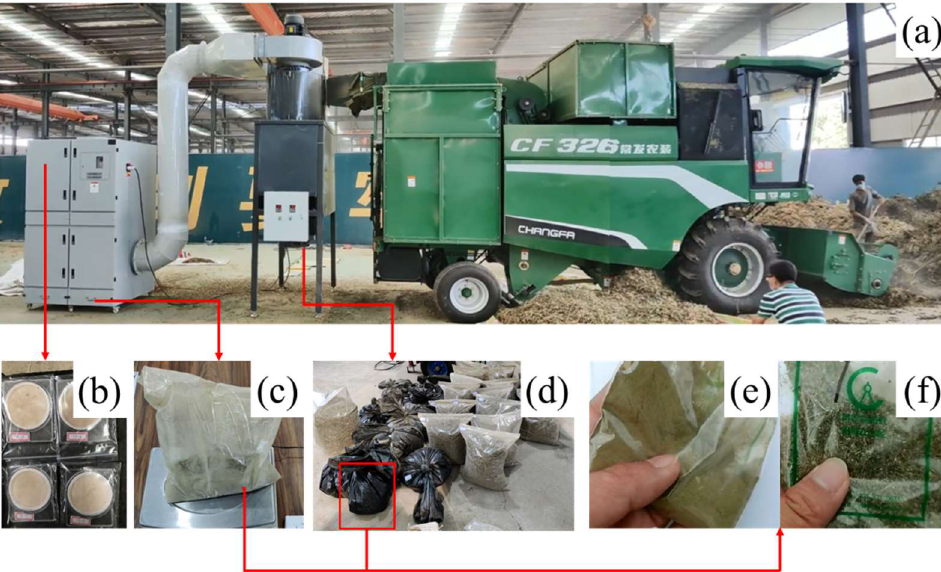
Figure 3. Total amount collection test of dust discharged from peanut whole-feed harvester: ( a ) Total amount collection test; ( b ) Dust sample at air flow outlet on filter membrane; ( c ) Dust sample collected by filter cartridge dust collector; ( d ) Dust sample (screened into coarse dust and broken stalks) collected by cyclone separator; ( e ) Soil particles from coarse dust; ( f ) Fiber particles from coarse dust.